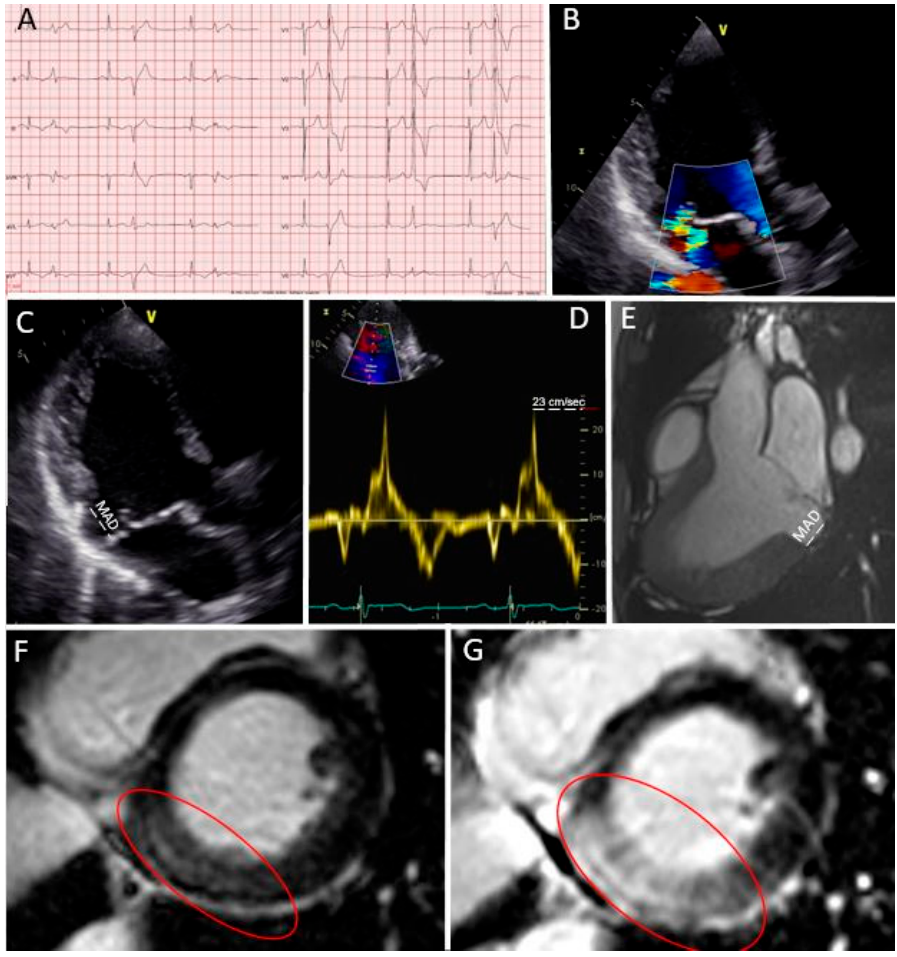
Figure 2. Case 1: Primary prevention ICD implantation after multi-modality imaging work-up. ( A ) Patient’s ECG; ( B ) moderate mitral regurgitation during color Doppler transthoracic echocardiography; ( C ) bileaflet prolapse with MAD (in white); ( D ) “Pickelhaube sign” during transthoracic echocardiography; ( E ) MAD measured in a steady-state free preces- sion three-chamber view during CMR; ( F , G ) a large zone of fibrosis in the basal inferior wall in LGE sequences (red circle).